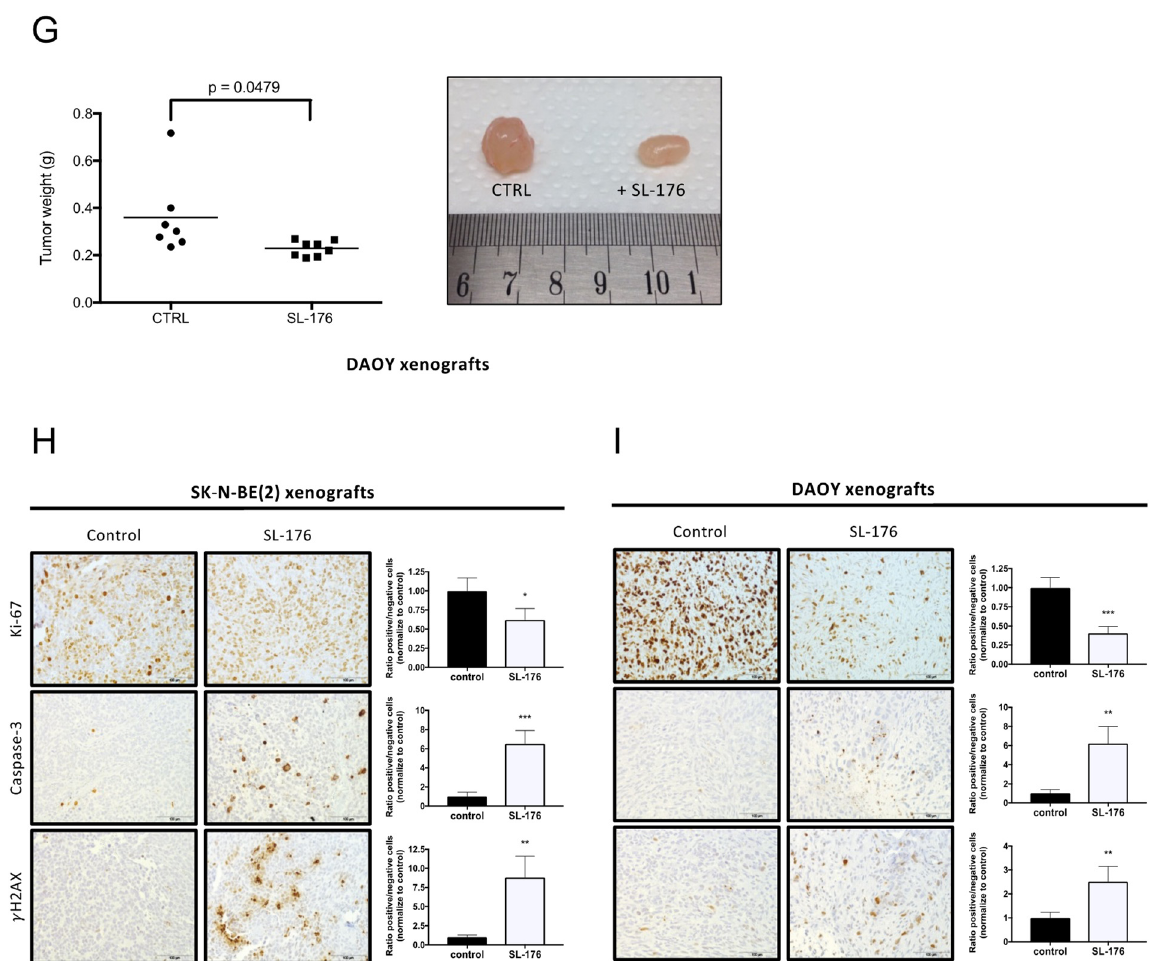
Figure 4. The WIP1 phosphatase inhibitor SL-176 suppresses neuroblastoma and medulloblastoma growth in vitro and in vivo. ( A ) SL-176 is more or equally efficient in inhibiting tumor cell viability among the WIP1 inhibitors tested. IC 50 values for four to six neuroblastoma cell lines and the PPM1D -amplified breast cancer cell line MCF-7 exposed to the WIP1 inhibitors SL-176, SPI-001, CCT007093 and GSK2830371. Horizontal lines indicate mean. IC 50 values were calculated from cell viability assays performed at least three times. SL-176 displayed a lower mean of IC 50 values than SPI-001 and CCT007093, while no difference was observed when comparing with GSK2830371 (mixed effects model on log IC 50 p < 0.0001, Bonferroni post-test: SL-176 vs. SPI-001 p < 0.0001, SL-176 vs. CCT007093 p < 0.0001, SL-176 vs. GSK2830371 p = 0.74). ( B ) SL-176 is an efficacious inhibitor of neuroblastoma cell viability. IC 50 values for eleven neuroblastoma cell lines, the breast cancer cell line MCF-7 and the fibroblast cell line MRC-5 exposed to the specific WIP1 inhibitor SL-176, the p53–MDM2 interaction inhibitor RITA or the MDM2 antagonist Nutlin-3. Horizontal lines indicate mean. SL-176 displayed the lowest mean of IC 50 values in the neuroblastoma cell lines of the three tested compounds (mean IC 50 for SL-176: 0.77 µ M; RITA: 2.0 µ M; and Nutlin-3: 3.7 µ M); however, a significant difference was only evident between SL-176 and Nutlin-3 (repeated measures one-way ANOVA on log IC 50 p = 0.030, Bonferroni post-test SL-176 vs. Nutlin-3 p = 0.0088, SL-176 vs. RITA p = 0.14). IC 50 values were calculated from the results of the cell viability assay WST-1 performed at least three times. ( C ) SL-176 inhibits medulloblastoma cell viability. IC 50 values for five medulloblastoma cell lines, the supratentorial primitive neuroectodermal (sPNET) tumor cell line PFSK-1 and the murine neural progenitor cell line C17.2 exposed to the specific WIP1 inhibitor SL-176, the p53–MDM2 interaction inhibitor RITA or the MDM2 antagonist Nutlin-3. Horizontal lines indicate mean. No significant differences between the mean IC 50 values were shown in these medulloblastoma cell lines (mean IC 50 for SL-176: 1.3 µ M, RITA: 1.1 µ M and Nutlin-3: 4.7 µ M, repeated measures one-way ANOVA p = 0.10). IC 50 values were calculated from the results of the cell viability assay WST-1 performed at least three times. MRC-5 and C17.2 were used as a non-tumorigenic control for drug toxicity. ( D , E ) SL-176 inhibit neuroblastoma ( D ) and medulloblastoma ( E ) growth in vivo. Nude mice were injected with neuroblastoma SK-N-BE(2) cells to form xenografts on the flank. Daily i.p. injections of SL-176 ( n = 14) for 12 days, starting at tumor volume 0.1 mL, compared to no treatment (CTRL, n = 6)